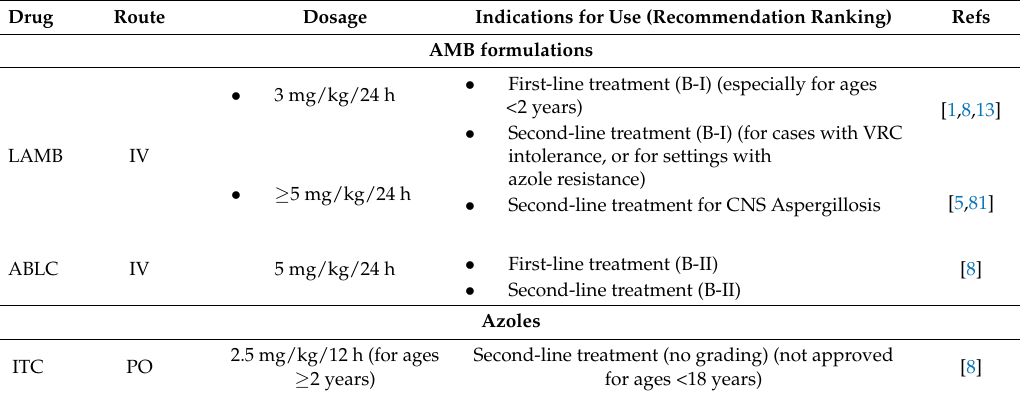
Table 4. Anti-fungal drugs for proven/probable Invasive